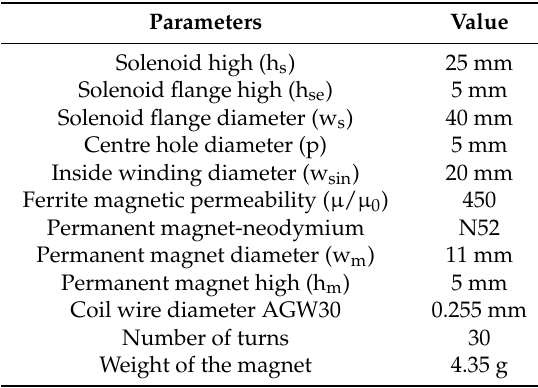
Table 1. EMAwS system